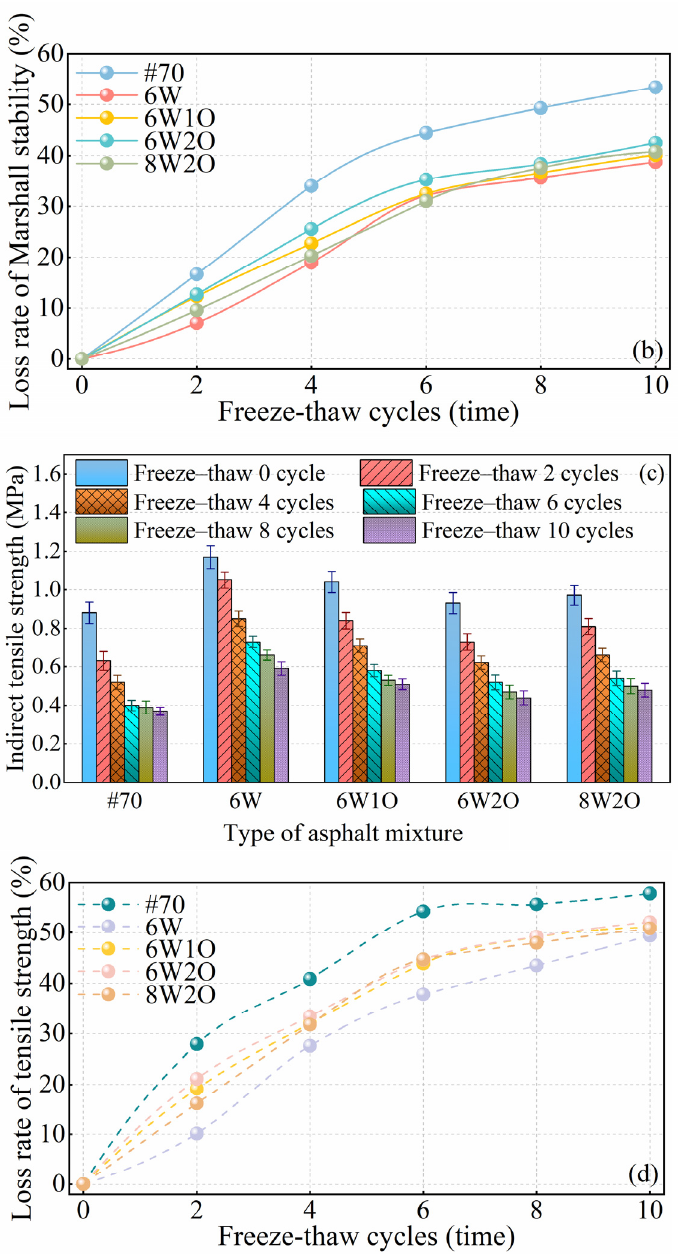
Figure 11. Test results of anti-freezing performance. ( a ) Test results of Marshall Stability after repeated freeze–thaw cycles. ( b ) Test results of loss rate of Marshall Stability after repeated freeze–thaw cycles. ( c ) Test results of indirect tensile strength after repeated freeze–thaw cycles. ( d ) Test results of loss rate of tensile strength after repeated freeze–thaw cycles.